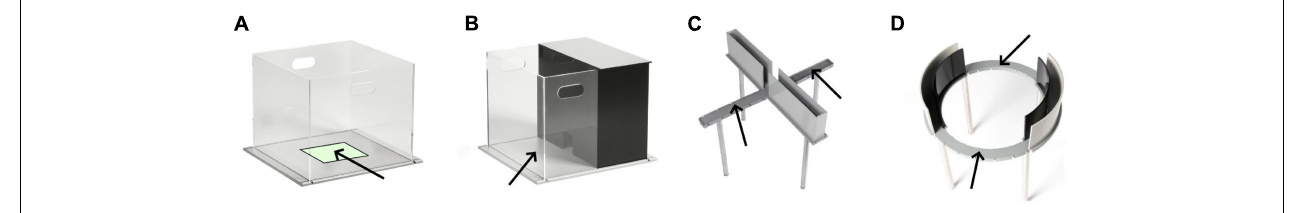
FIGURE 1 | Common apparatuses for measuring unconditioned anxiety-like behaviors in rodents: (A) Open field, (B) Light-dark box, (C) Elevated plus maze, (D) Elevated zero maze. Arrows point to anxiogenic (lit and exposed) regions of the apparatus. Images from Stoelting,